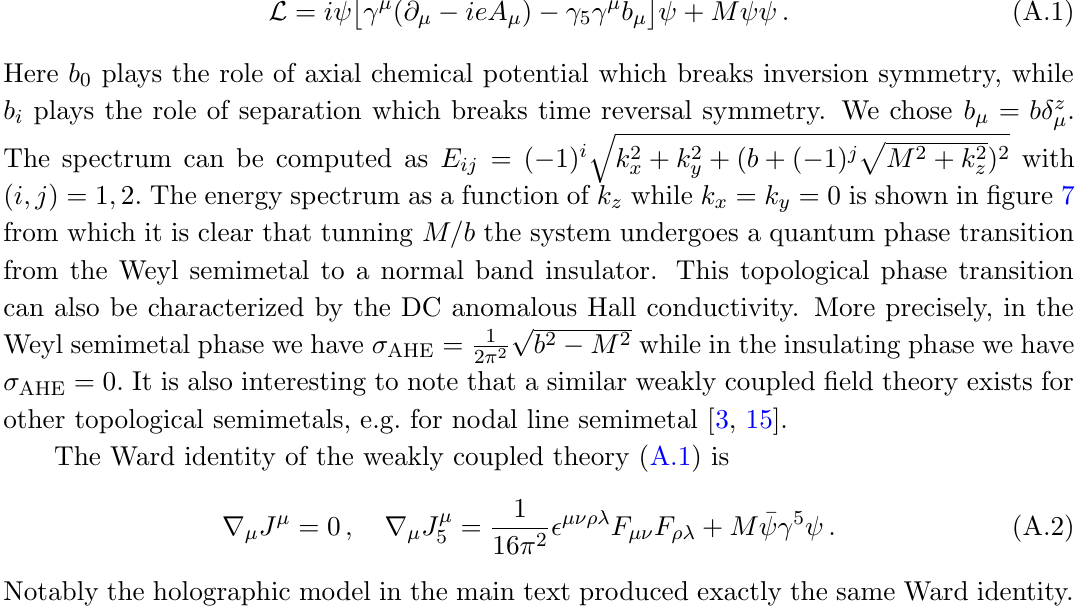
Figure 7 . The energy spectrum as a function of k z in the weakly coupled theory. Left: when M < b , there are Weyl points separating by an e(cid:11)ective separation 2 system is in the Weyl semimetal phase. Right: when M > b , there is a band gap with 2( M (cid:0) b ) in the spectrum and the system is in an insulating